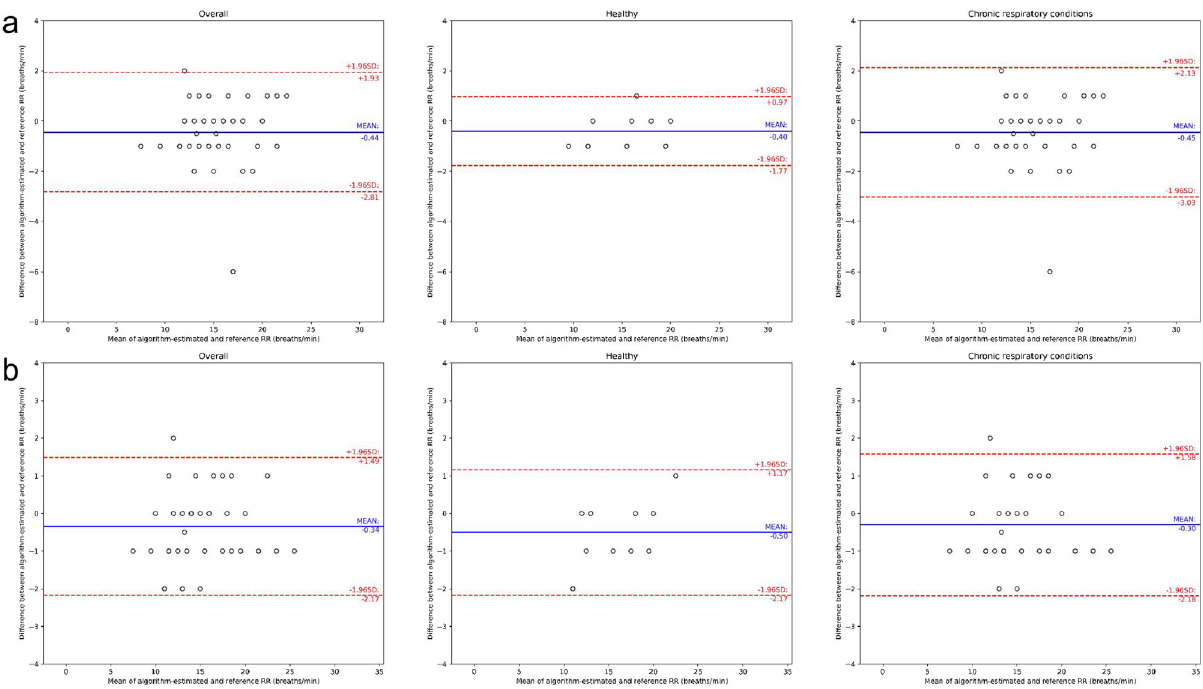
Fig. 3 Bland – Altman plots for the respiratory rate (RR) study. Results are presented for a algorithm version A ( n = 50) and b algorithm version B ( n = 50). From left to right, plots are respectively results for the full study followed by subgroups based on absence vs. presence of chronic respiratory conditions. The reference RR was obtained by research coordinators manually counting breaths (see Methods). Dots represent individual participants; blue lines indicate the mean difference; red lines indicate the 95% limits of agreement (mean difference ± 1.96 standard